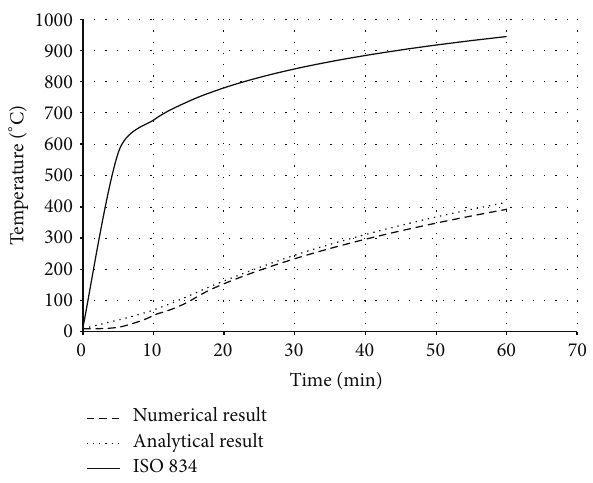
Figure 11: Comparison of 𝑇 - 𝑡 Curves at point